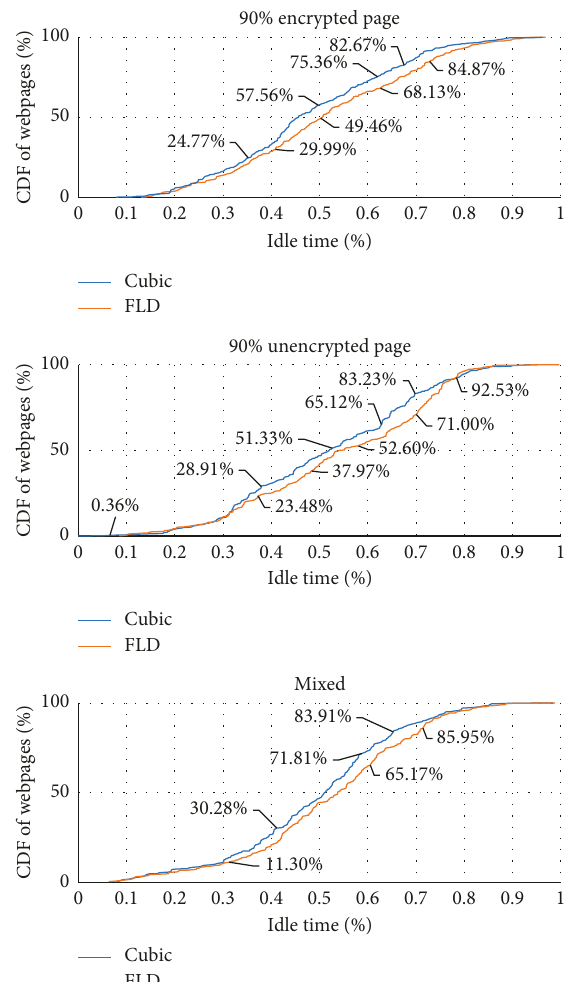
Figure 7: Distribution of idle time inside pages for different page